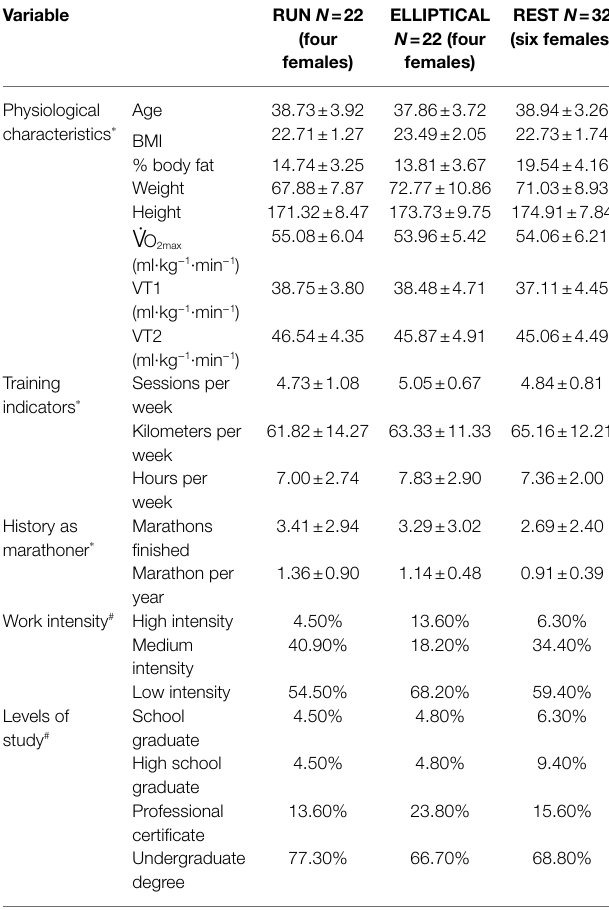
TABLE 1 | Description of study